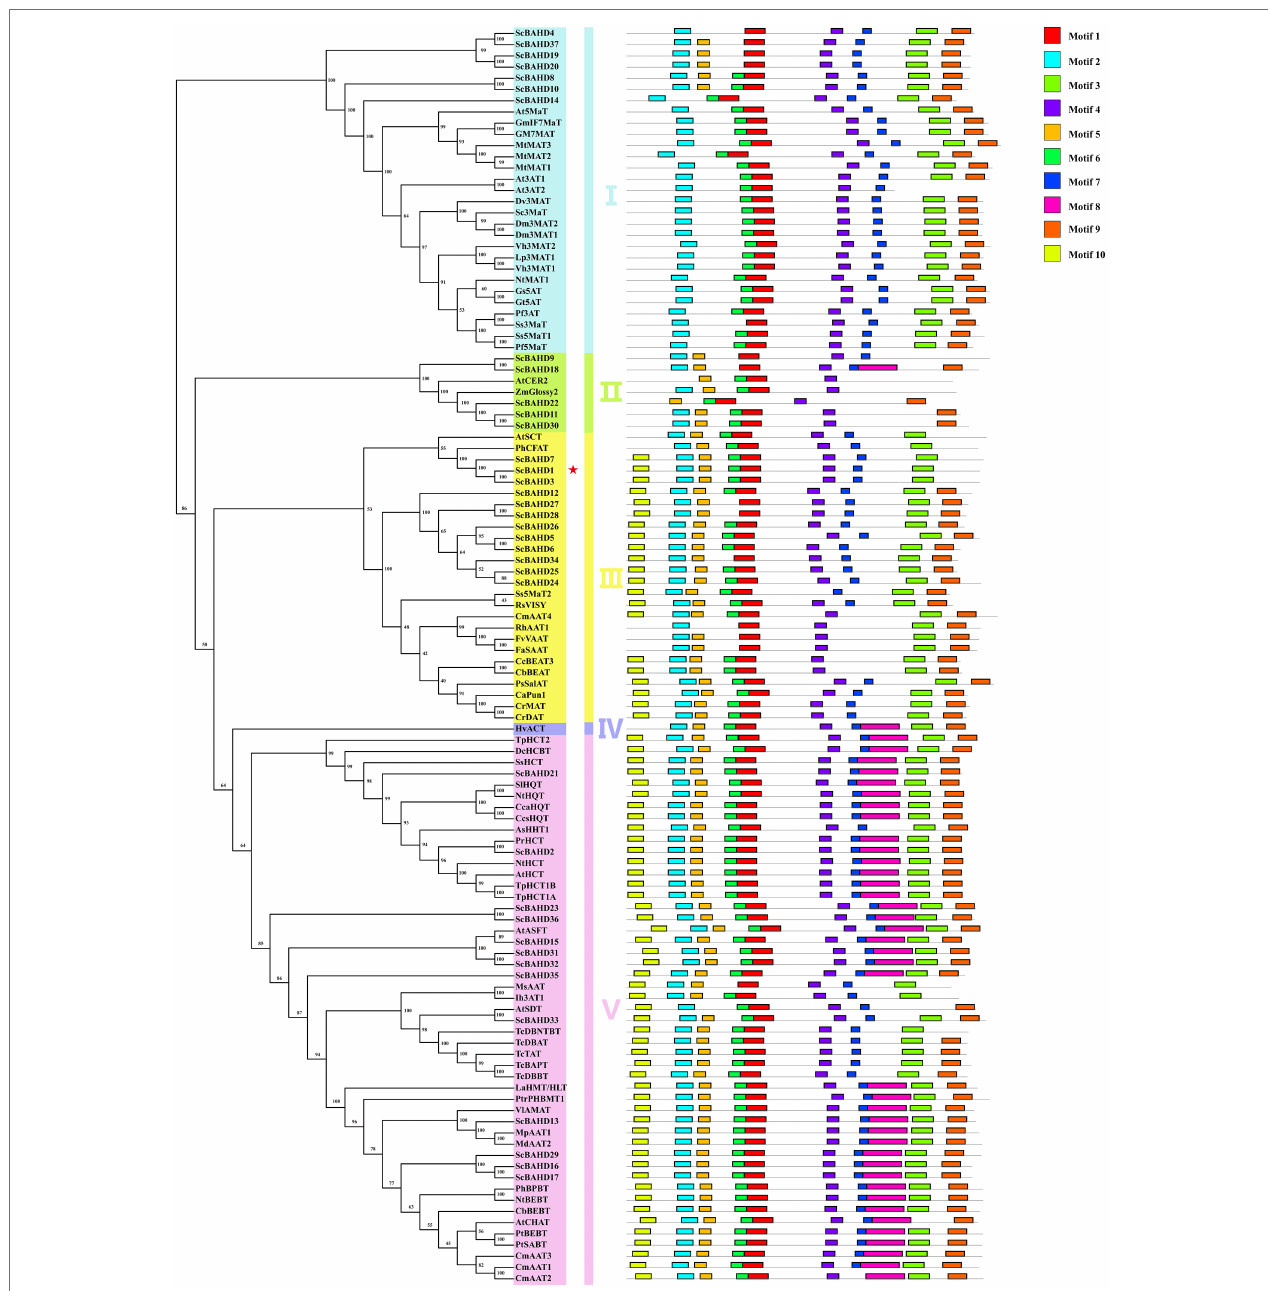
FIGURE 3 | Maximum likelihood phylogenetic tree and conversed motif of 75 biochemically characterized BAHD acyltransferases and 37 putative ScBAHD acyltransferases. The five clades are shown in different